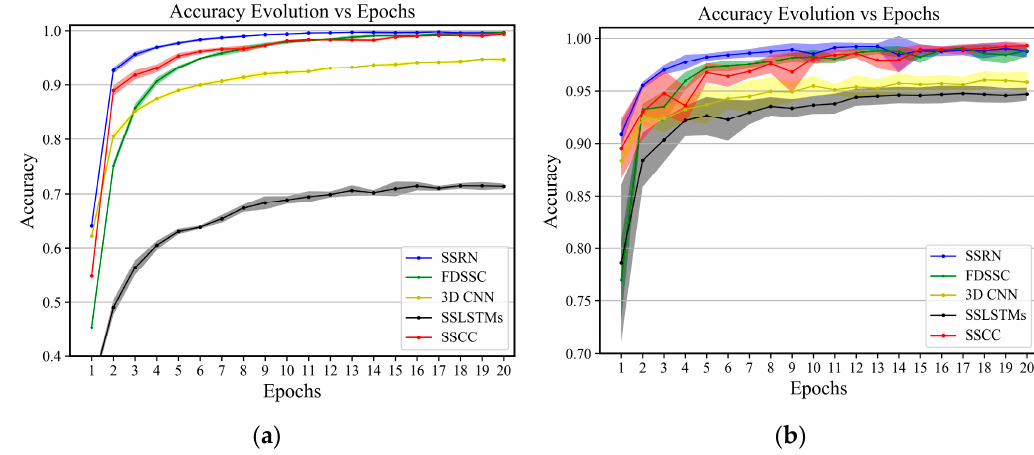
Figure 18. Pavia Center: Evolution of the accuracy in terms of epochs on ( a ) training data and ( b ) validation data. The shadow shows the standard deviation of the accuracy for five executions.